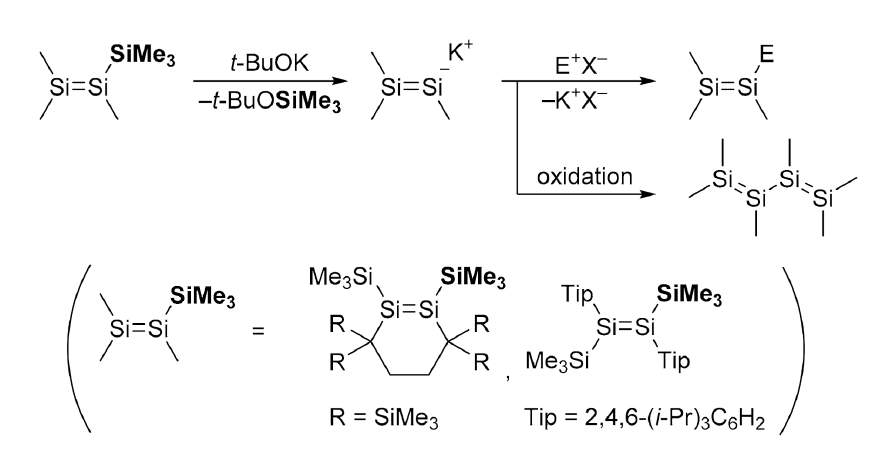
Scheme 1. Selective desilylation and subsequent reactions of trimethylsilyl-substituted